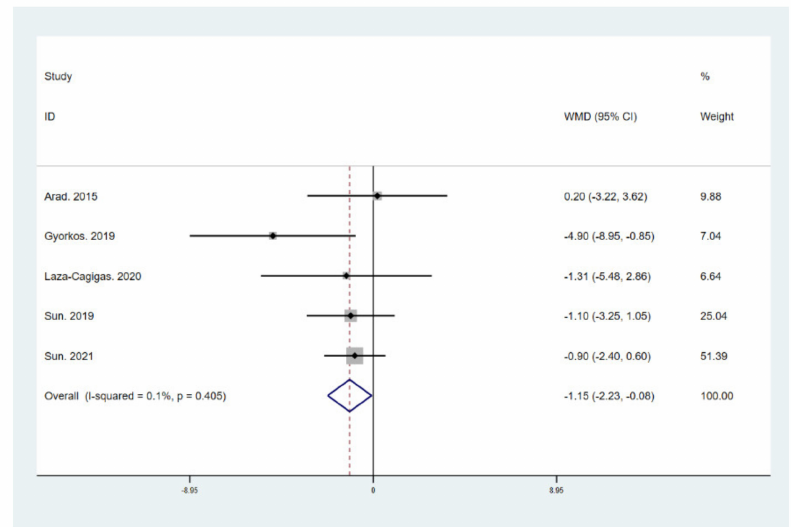
Figure 5. Forest plot for the effect of a low-carbohydrate high-fat (LCHF) diet combined with HIIT on body mass index (BMI). For each study, squares represent the mean difference in intervention effects, with horizontal lines intersecting them as the lower and upper limits of the 95% CI. The size of each square represents the relative weight of the studies conducted in the meta-analysis. The diamond represents the results of the meta-analysis combining the individual studies.